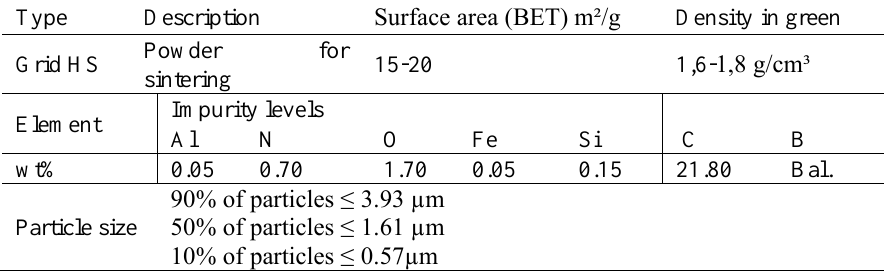
Table 2. B 4 C powder